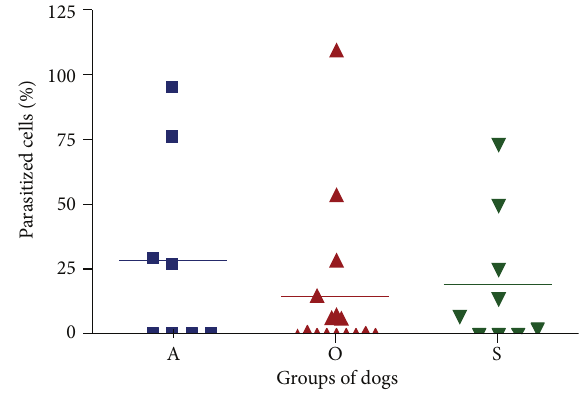
Figure 2: Proportion of parasitized cells in bone marrow of dogs with visceral leishmaniasis. Note the marked variation in mean of infected cells in the three groups of dogs. There was no significant difference between groups by Kruskal-Wallis test (𝑃 > 0.05)